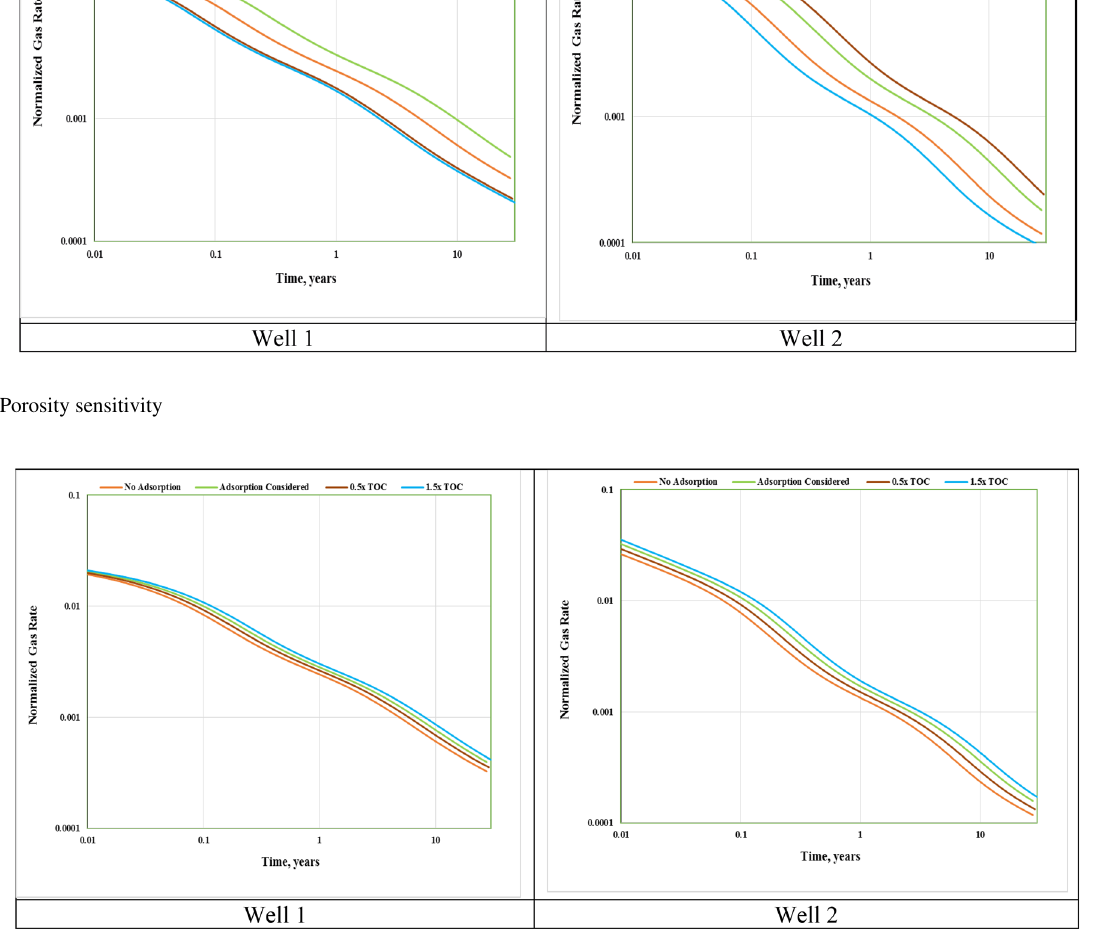
Fig. 17 Adsorption